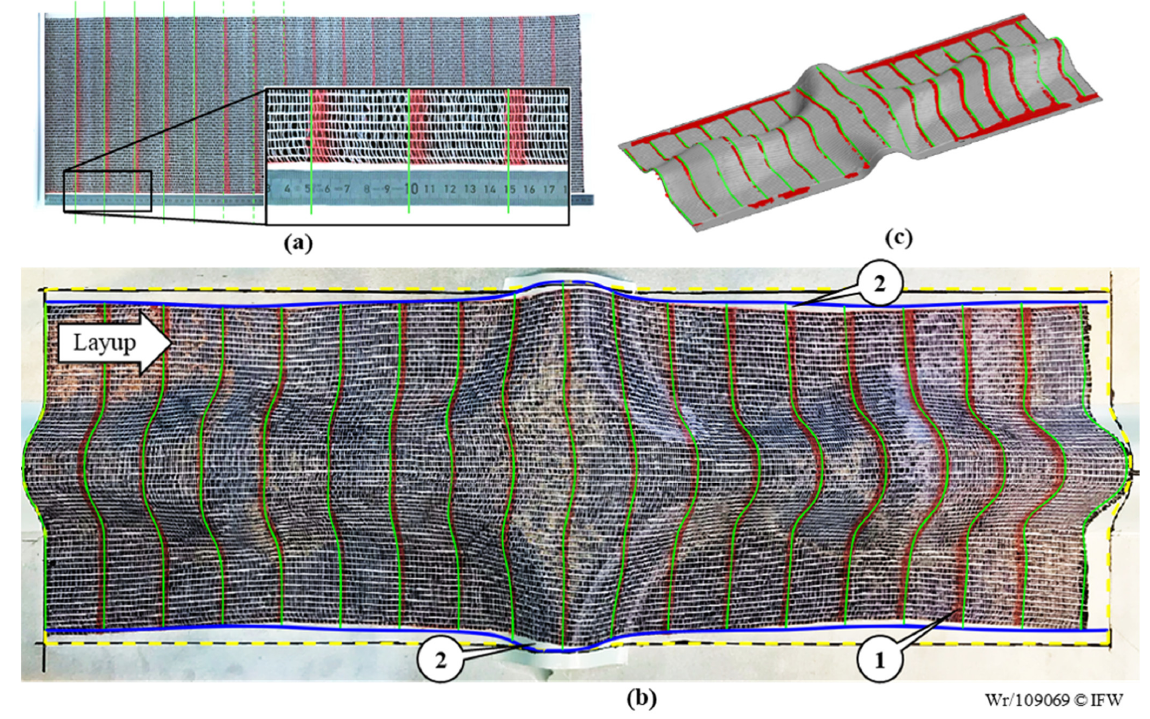
Figure 4. ( a ) 900 × 300 mm 2 UD-NCF with lateral lines from red spray paint; ( b ) comparison of a 2D image of the experi- mental draping result with a perspective plot of the simulation; ( c ) comparison of the simulation with a 3D surface scan.